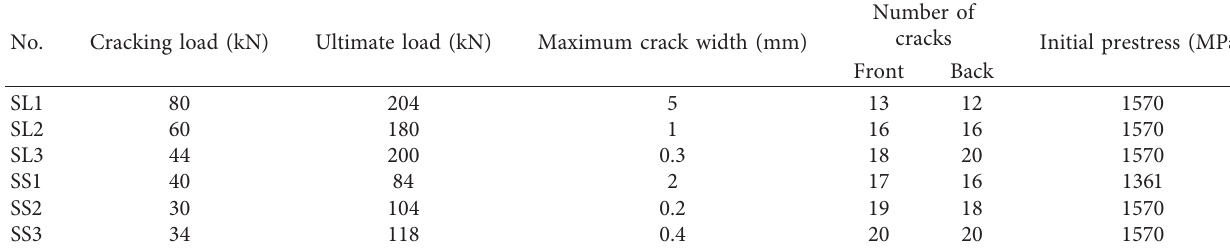
Table 2: Initial damage of each damaged